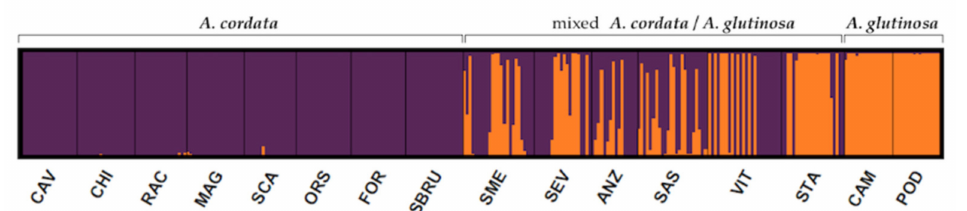
Figure 4. Genetic structure of 16 Alnus populations (8 pure A. cordata , 2 pure A. glutinosa , 6 mixed A. cordata/A. glutinosa ) (core Group I = purple; core Group II = orange).